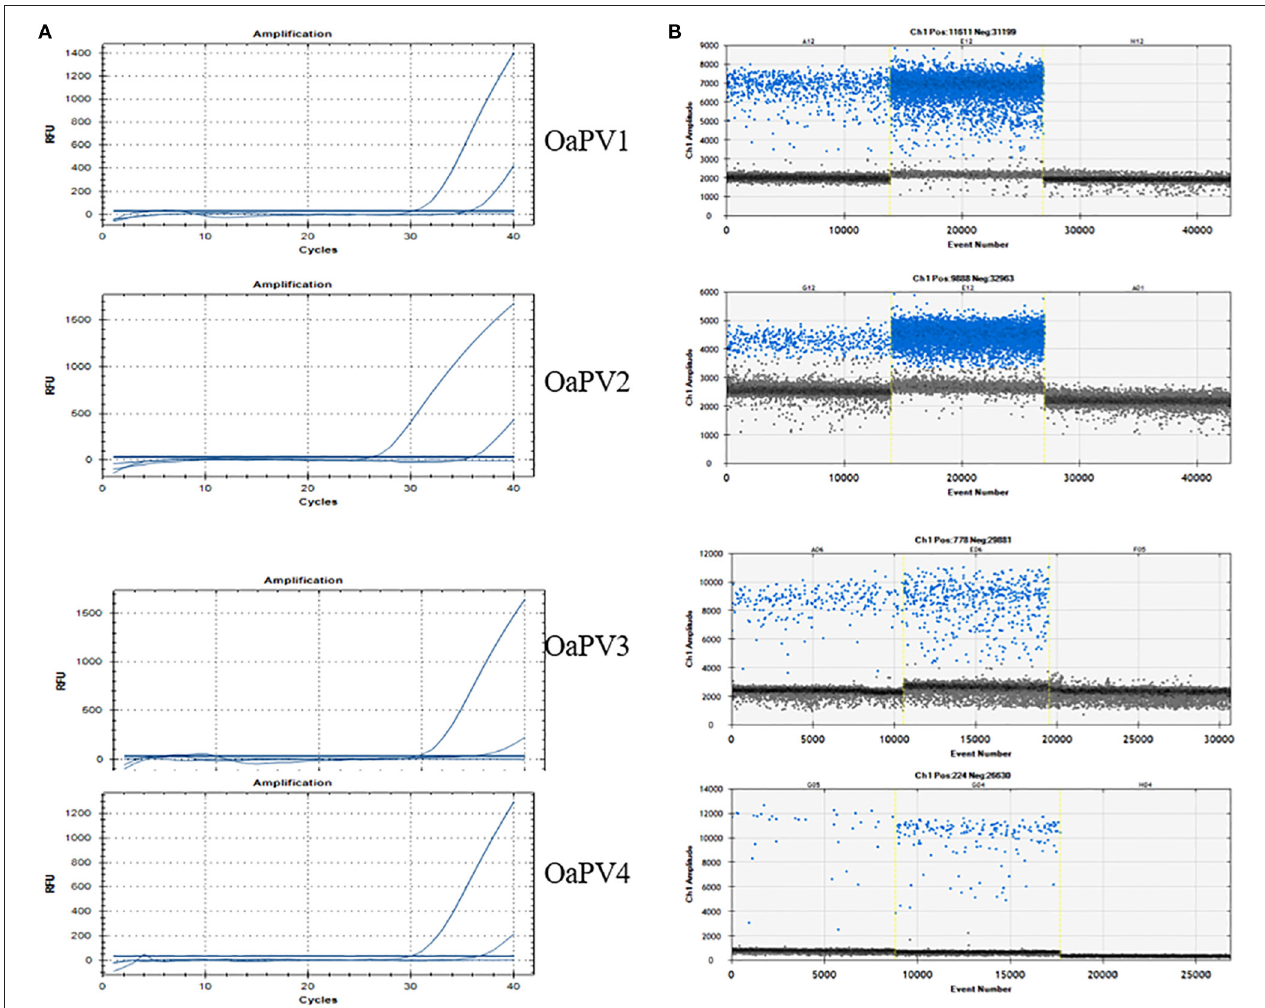
FIGURE 2 | qPCR curves (A) and the relative rain plots of the ddPCR (B) for the four OaPVs. For all OaPVs one positive sample, the positive control, and one negative sample are shown.